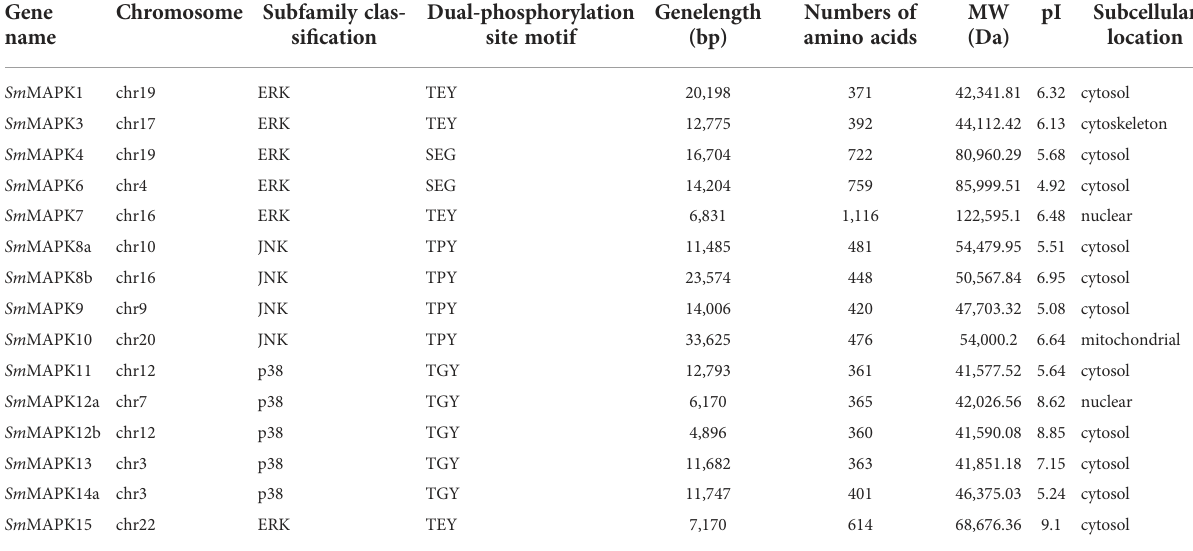
TABLE 1 Summary of the sequence characteristics of MAPK genes in Scophthalmus maximus